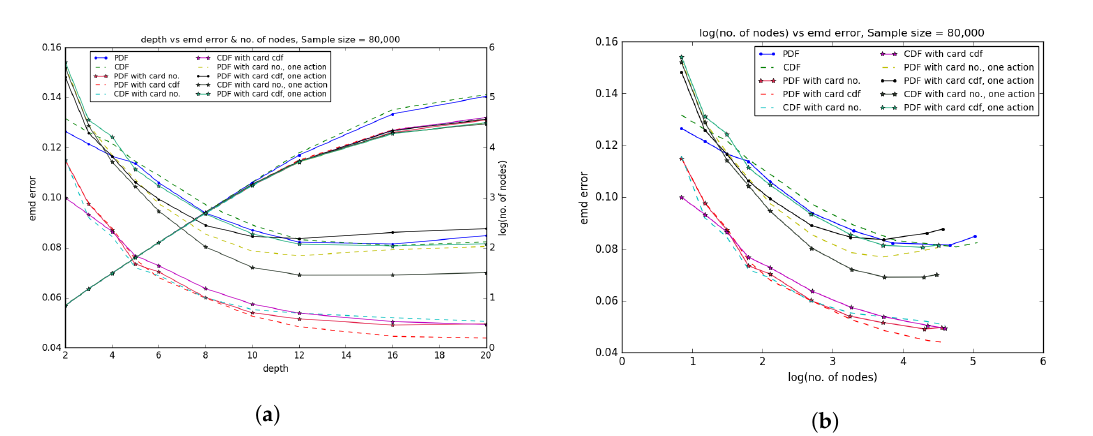
Figure 4. Depth vs. #nodes and error; error curves are decreasing in depth, #nodes are increasing (Figure 4a). Number of nodes vs. error in decision tree (Figure